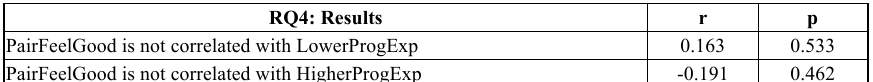
Table 9. Results summary of RQ4